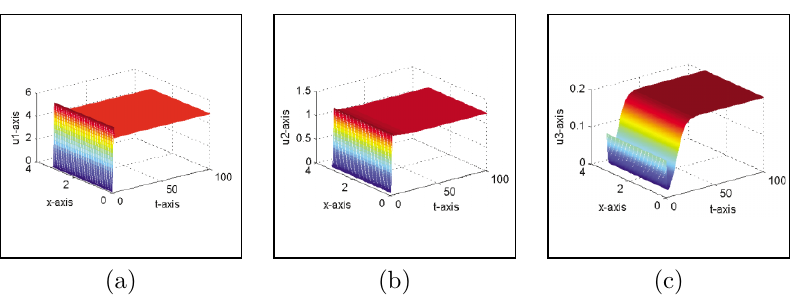
Figure 1. The time dependent solution found by numerical integration with r 1 = 6, r 2 = r 3 = 1, a 11 = a 12 = a 21 = 1, a 22 = 3, a 23 = a 32 = a 33 = 1, d 1 = 1, d 2 = 2, d 3 = 1, τ 1 = τ 2 = 0 . 1; φ i ( x, 0) = 0 . 1 ( i = 1 , 2 , 3); ∂u i /∂x = 0 ( i = 1 , 2 , 3), t ≥ 0, x = 0 ,π .